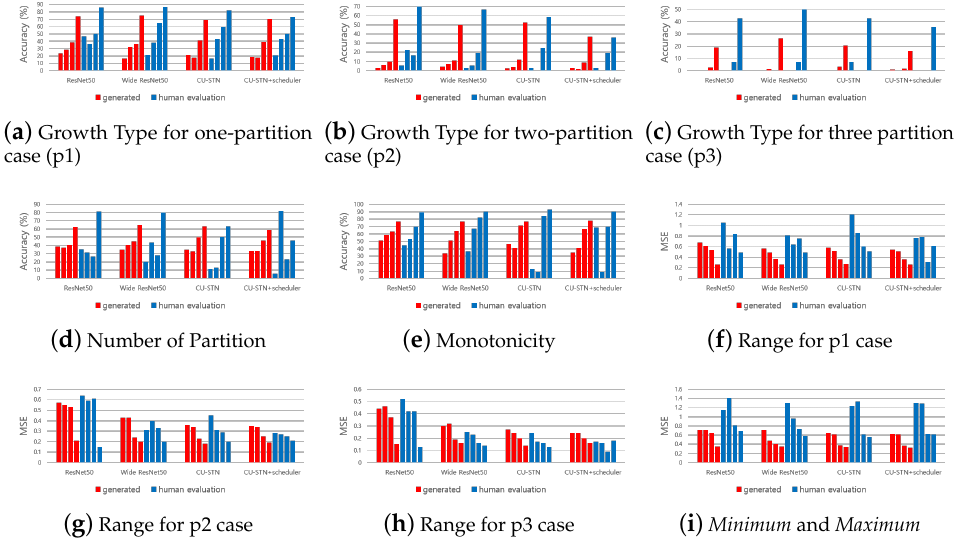
Figure 7. Comparison of synthetic data (red) and human evaluation data (blue). Bars are the accuracy and MSE for classification and regression, respectively. Bars in the same color are the results of models trained with 1000, 5000, 10,000, and 50,000 samples from the leftmost side. Overall subtasks result show similar tendencies. Detailed numerical results of the tests are shown in Tables 6 and 7. Table 8. Performance for all subtasks in synthetic validation data (tr., training; va., validation; part., the number of partitions; mono., monotonicity; super., superiority; | D tr | , size of training and validation data; W-ResNet-50-2: